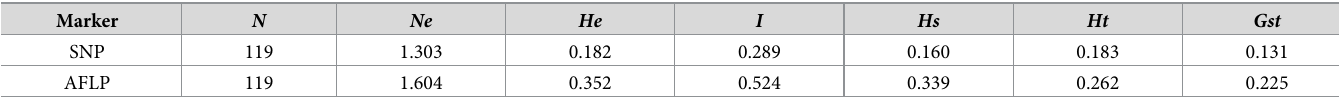
Table 8. Genetic diversity mean values obtained with each type of marker for K = 2 in the subset of 119 accessions.